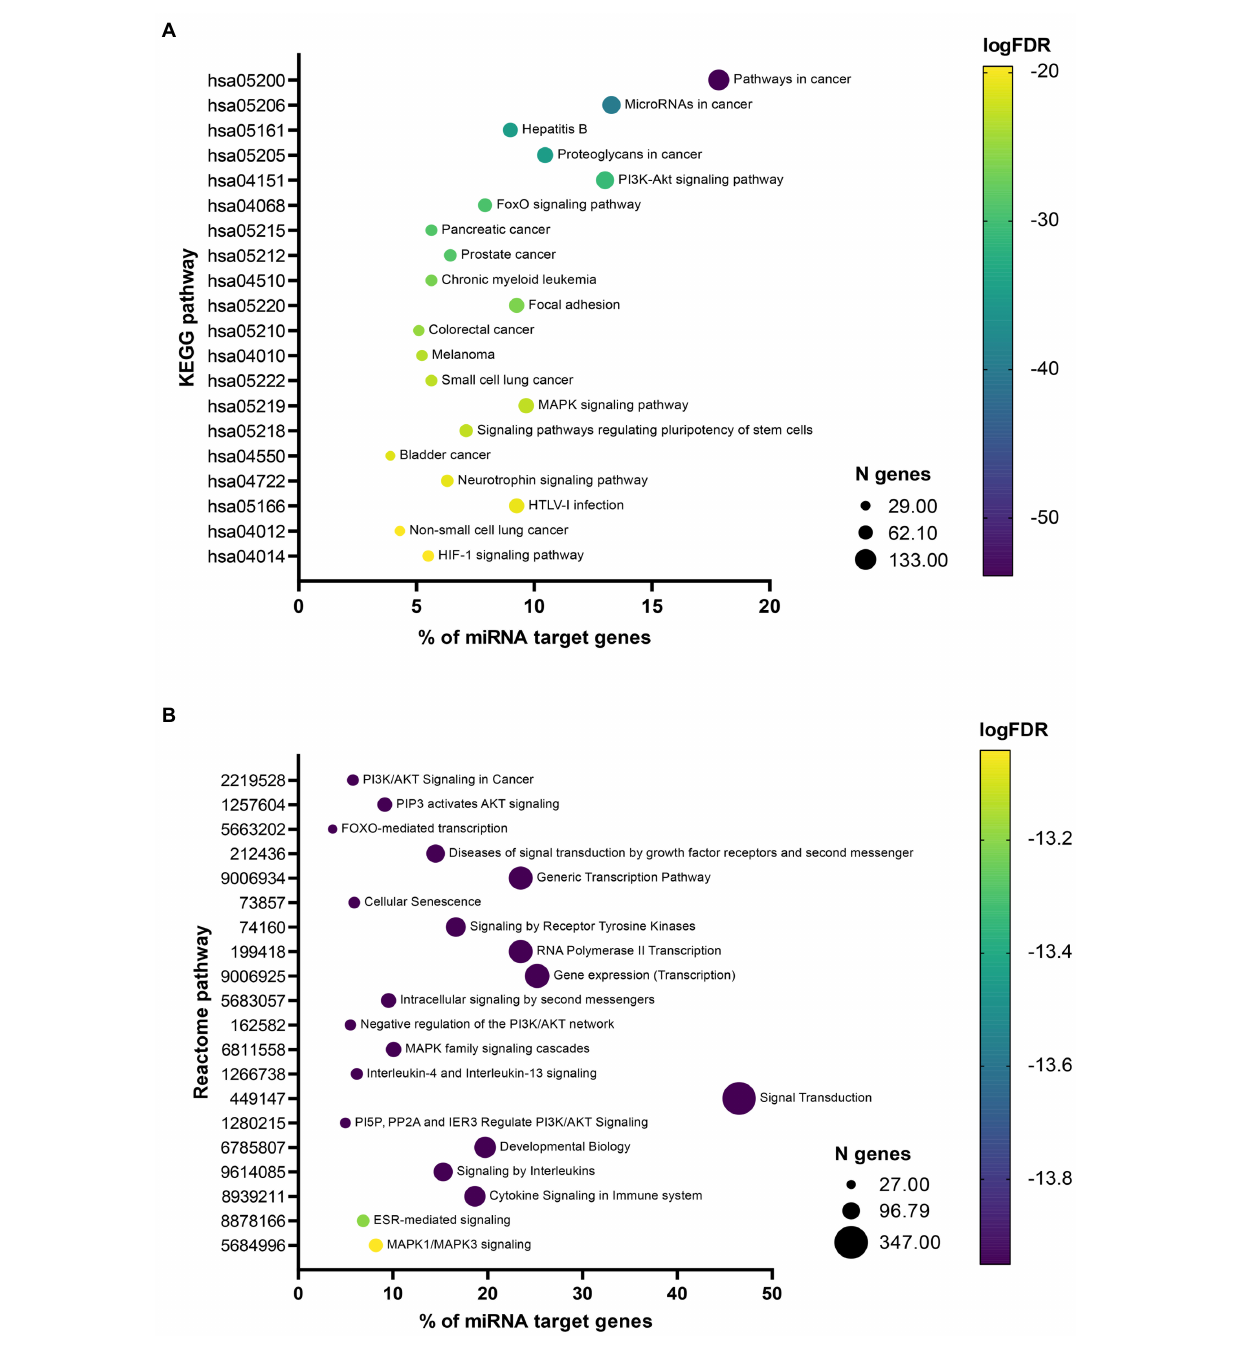
FIGURE 3 Bubble plots showing most significant enriched pathways. Bubble plots showing 20 most significant enriched Kyoto Encyclopedia of Genes and Genomes (KEGG) (A) and Reactome (B) pathways. The x-axis represents the percentage of 746 miRNA target genes associated with a specific pathway represented on the y-axis. Size of the bubble represents the number of genes associated with a specific pathway and the color of the bubble reflects the p -value after false discovery rate (FDR)